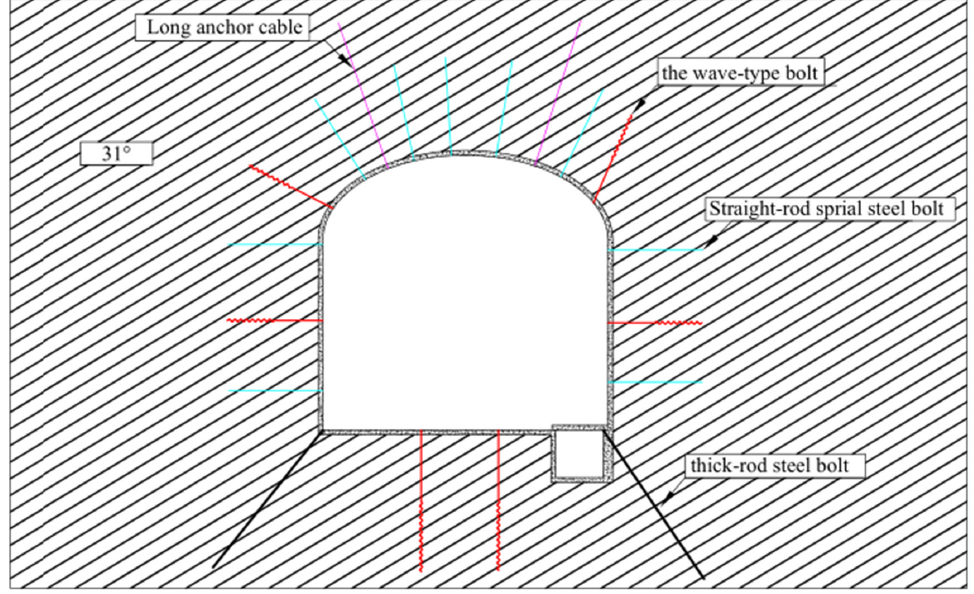
Figure 14. Sketch of the new roadway support schemes.